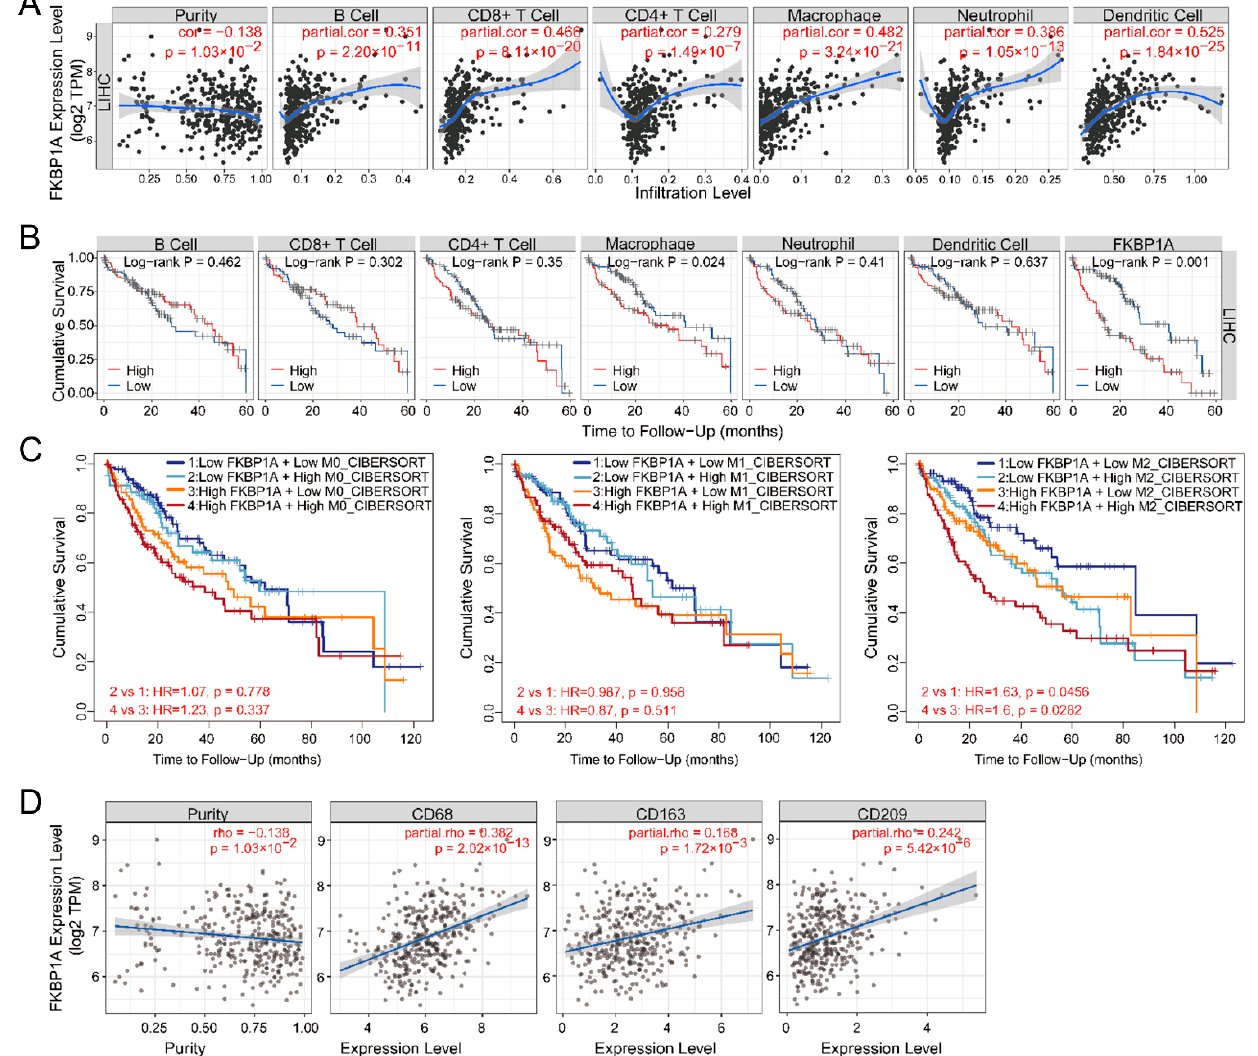
Figure 8. Correlation analysis between FKBP1A expression and tumor-infiltrating immune cells in LIHC. ( A ) FKBP1A expression is significantly related to tumor purity and has significant positive correlations with infiltrating levels of B cells, CD8 + T cells, CD4 + T cells, macrophages, neutrophils, and dendritic cells obtained from TIMER (purity-corrected Spearman test) in LIHC. ( B ) Five-year overall survival curve of the six tumor-infiltrating immune cells and FKBP1A expression in LIHC patients produced by Kaplan–Meier estimator from TIMER. Survival differences are compared between patients with high and low (split percentage of patients is 30%) infiltration of each kind of immune cells. Log-rank p < 0.05 is considered significant. ( C ) The Kaplan–Meier plot from the TIMER2.0 shows the difference of overall survival among patients stratified by both the estimated infiltration level of different types of macrophages (M0, M1 and M2) and FKBP1A expression level in LIHC. ( D ) Scatter plots from the “Gene Module”. Correlation of FKBP1A expression with tumor purity and with the infiltration level of M2 macrophage markers CD68 , CD163 and CD209 . p < 0.05 is considered significant.